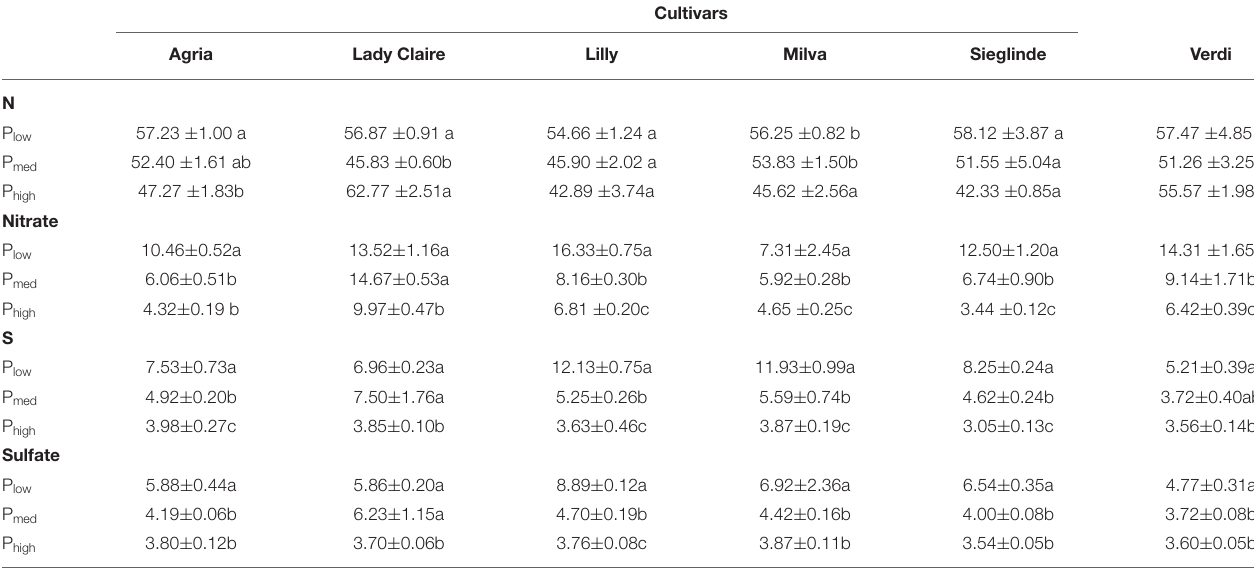
Cultivars Agria Lady Claire Lilly Milva Sieglinde